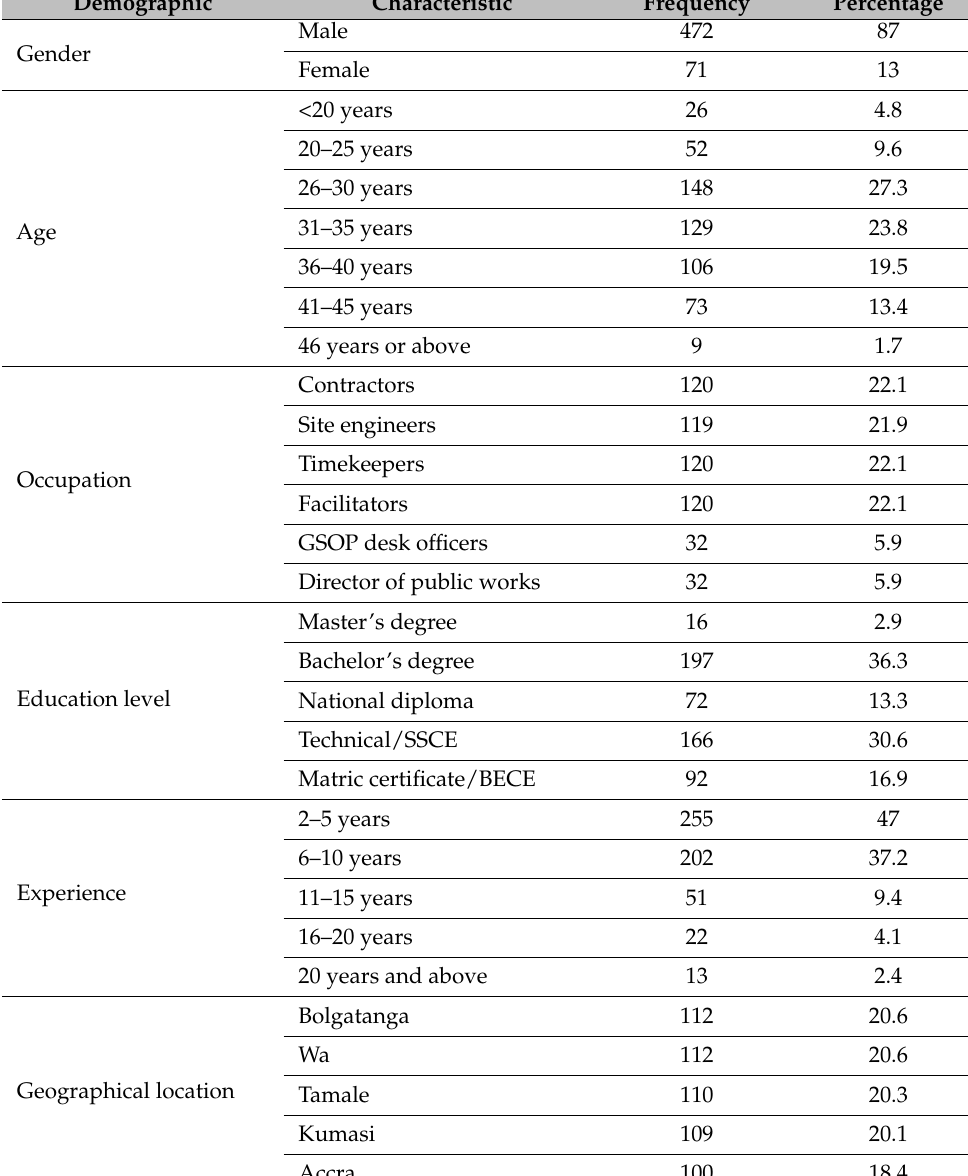
Table 1. Profiles of